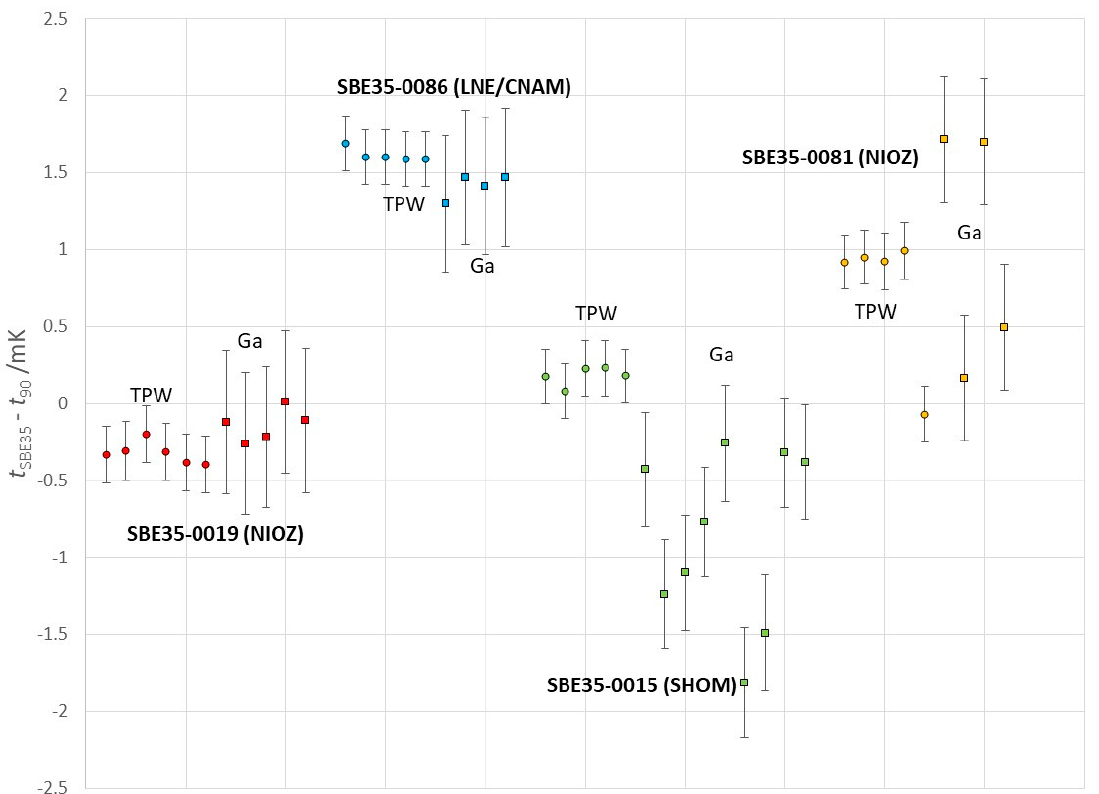
Figure 3. Fixed-point recalibration of 4 different SBE35 units—s/n 0019 from NIOZ, s/n 0086 from LNE/CNAM, s/n 0015 from SHOM, and s/n 0081 from NIOZ. The circles corresponds to TPW calibrations and the squares corresponds to Ga calibrations. The bars represent the uncertainties in the fixed-point recalibration (0.186 mK for TPW and 0.464 mK for Ga, see Table 1).